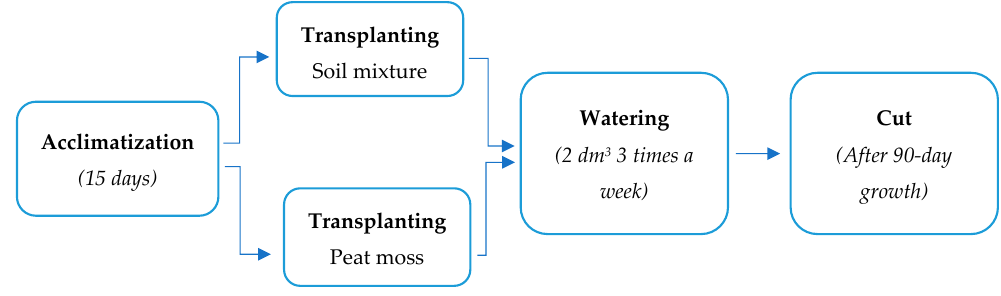
Figure 8. Experimental procedure.